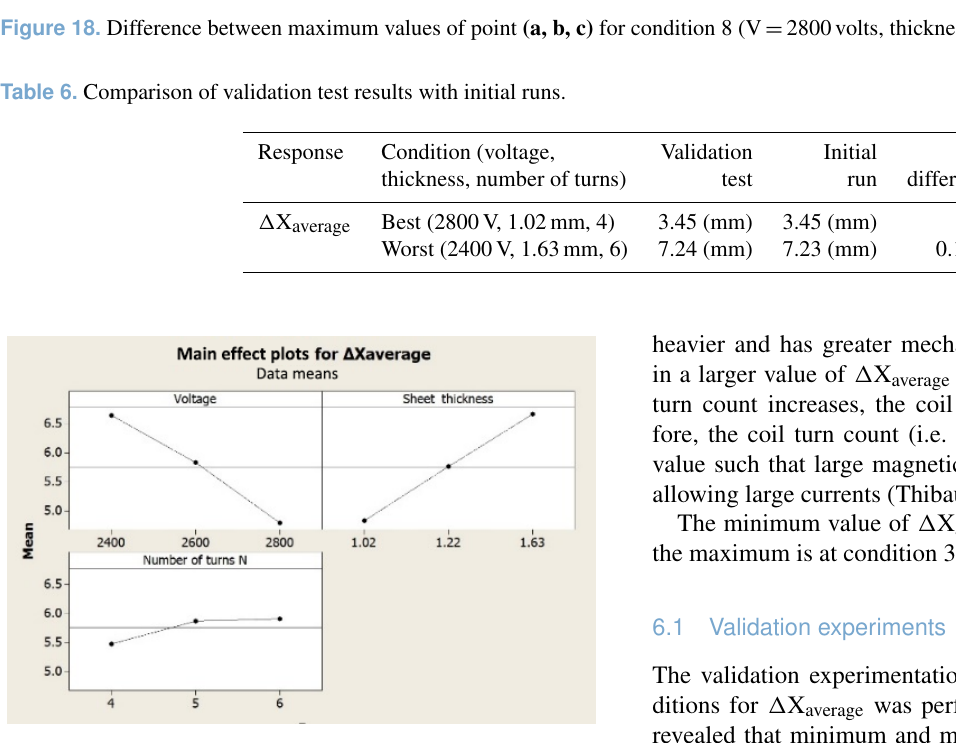
Figure 19. Effect of processing parameters on (cid:49) X average .